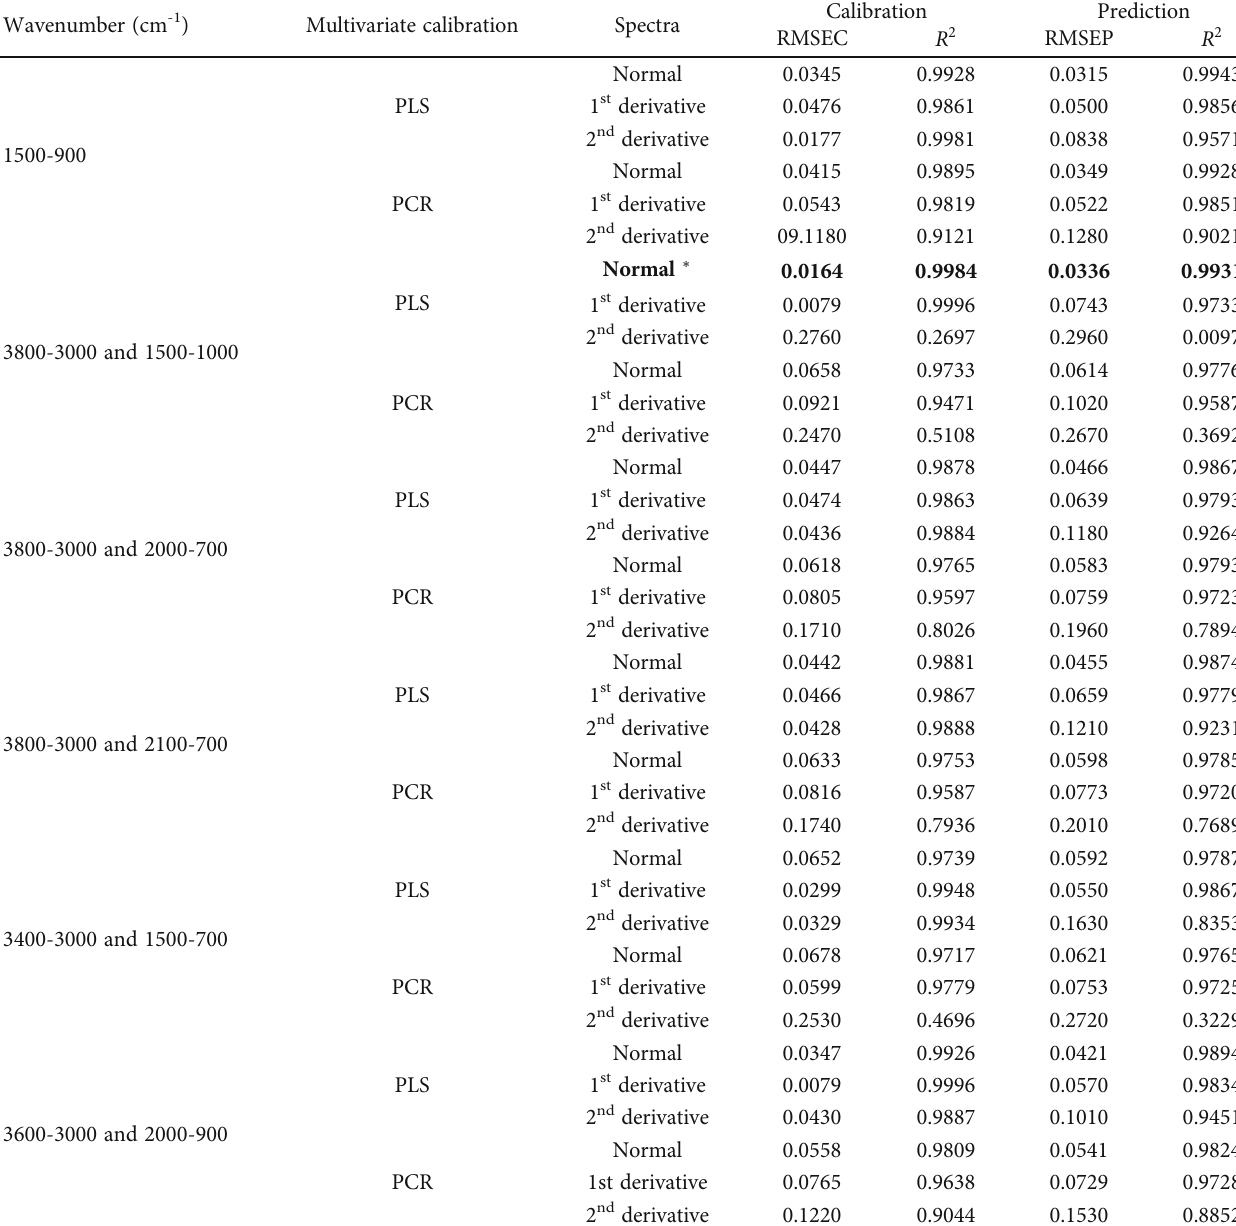
Table 4: The optimization wavenumber region of multivariate calibration for authentication of horse ’ s milk (HM) from cow ’ s milk (CM). Wavenumber (cm -1